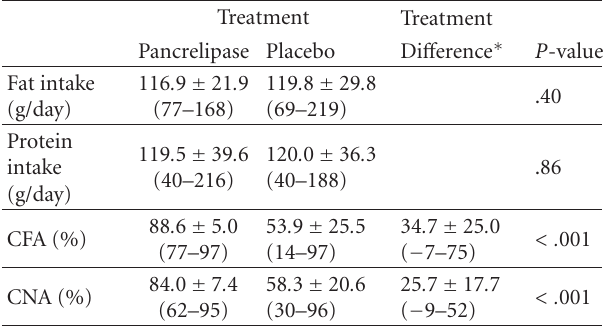
Table 2: Dietary intake and absorption in the mITT population ( n =